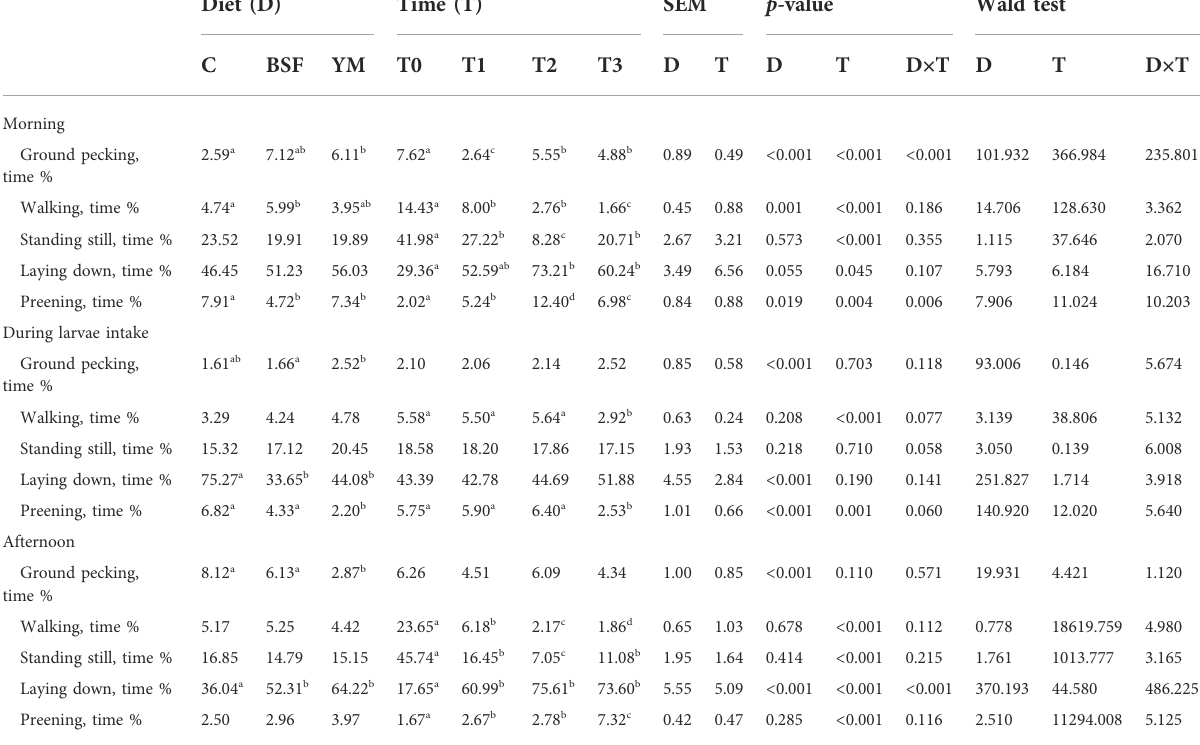
TABLE 4 Duration behaviours of the broiler chickens depending on diet, time and their